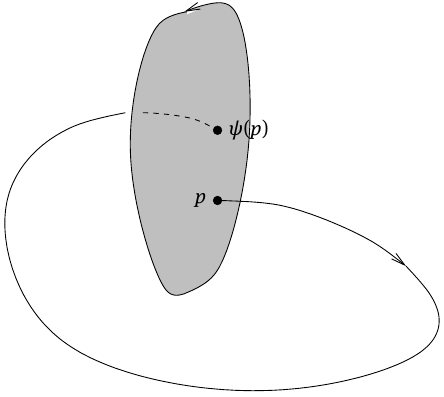
Figure 10: A disc-like global surface of